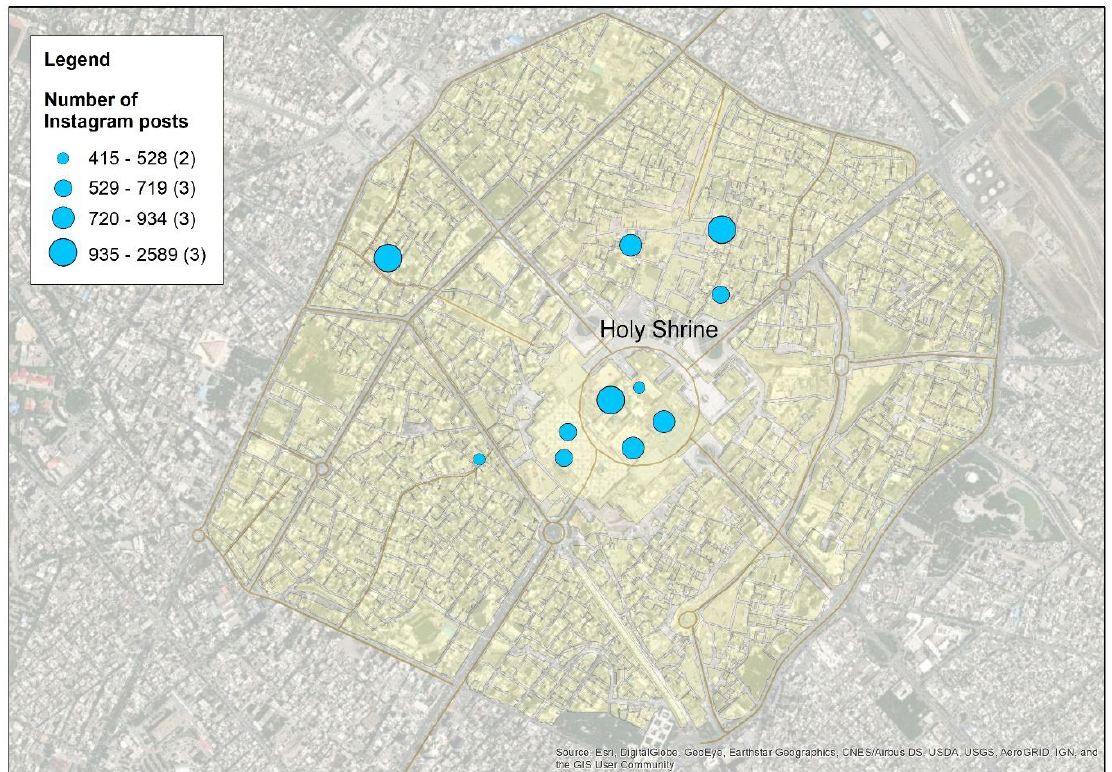
Figure 7 Distribution of 11 locations around Holy